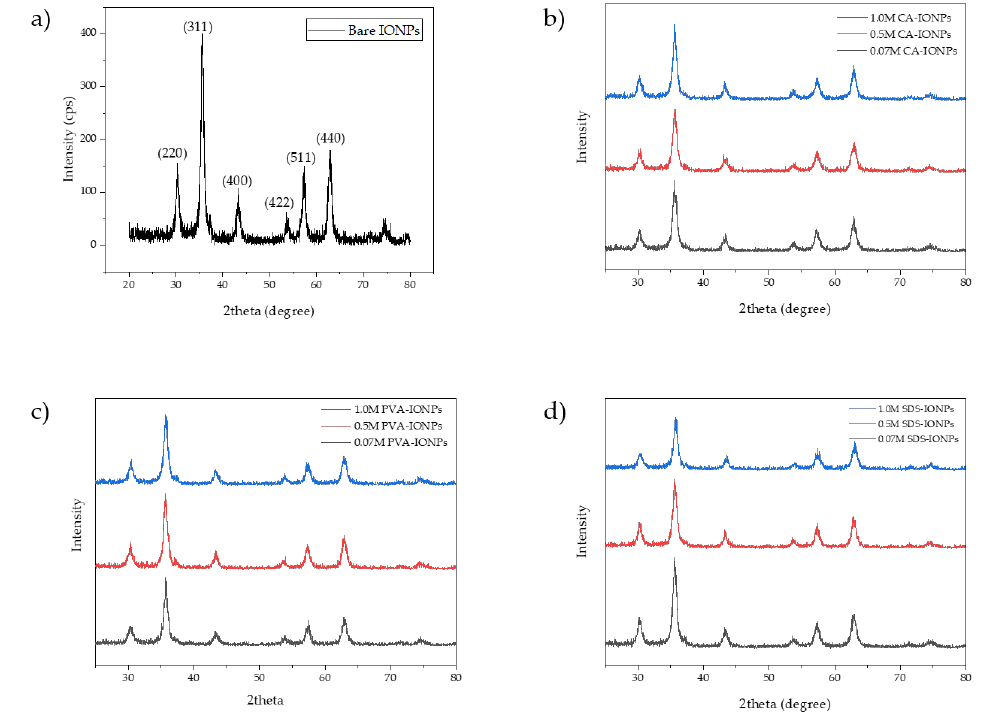
Figure 2. XRD peaks of ( a ) bare IONPs and various molar ratios of ( b ) CA-IONPs, ( c ) PVA-IONPs and ( d ) SDS-IONPs.